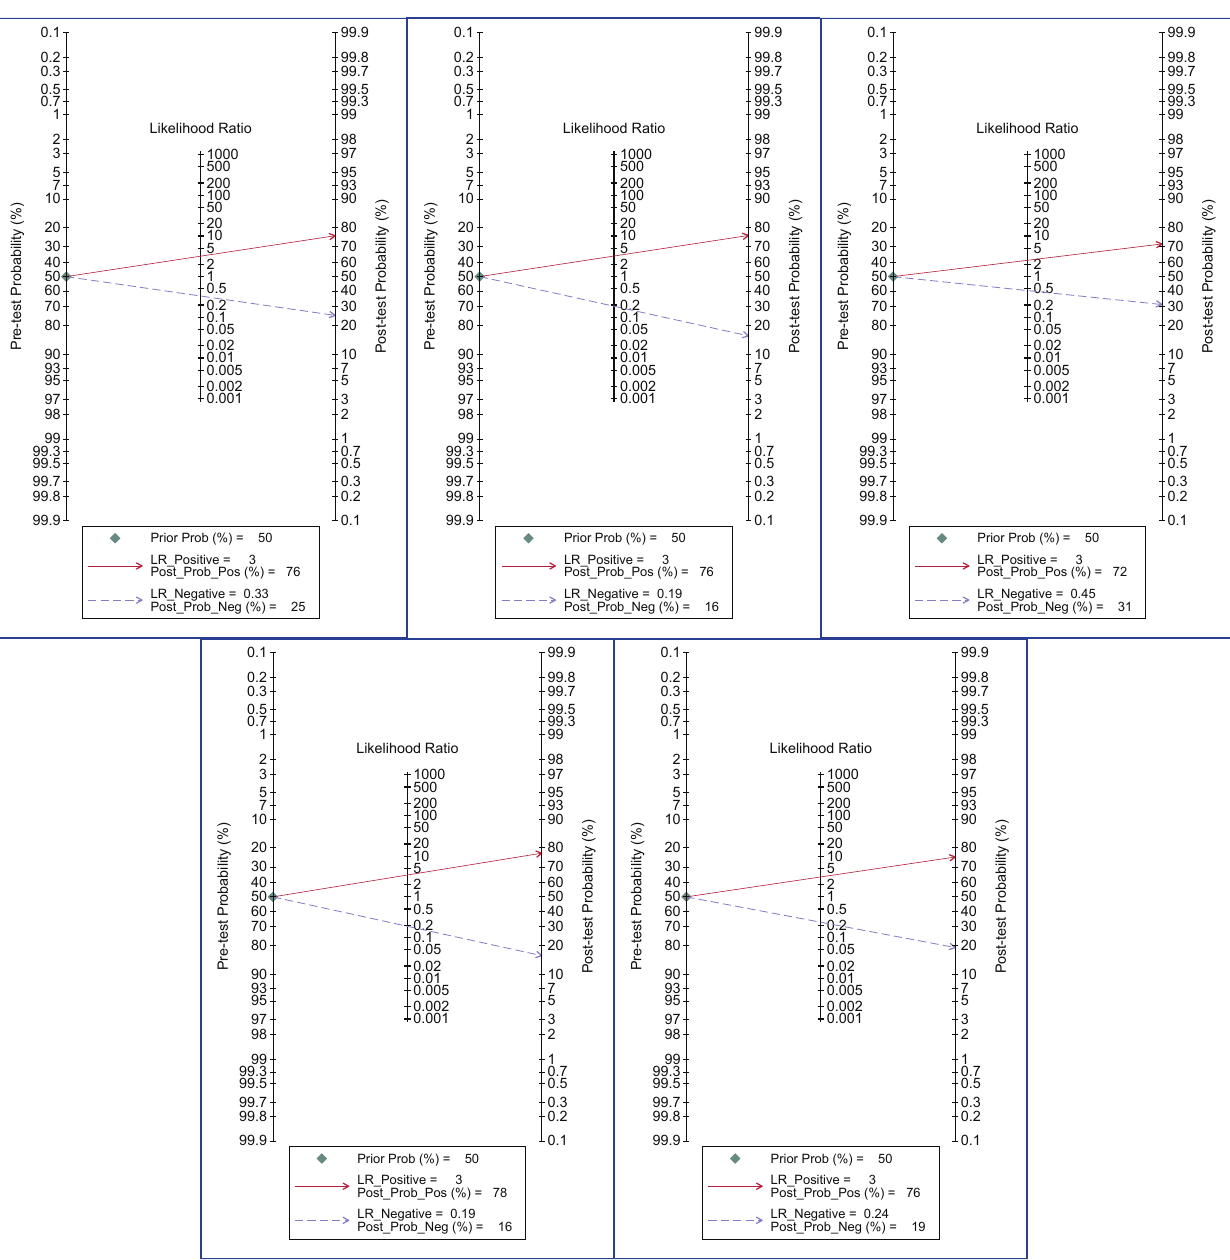
Additional file 4 Fagan nomogram of RRI for predicting AKI in subgroups of critical ill